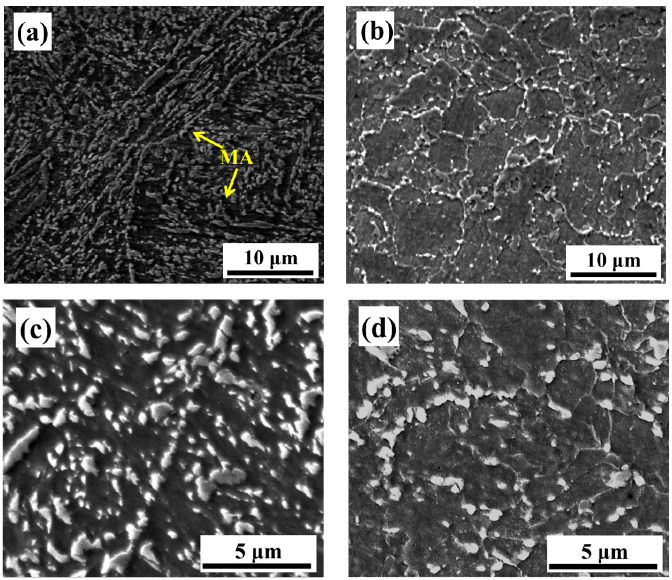
Figure 4. Microstructure of the weld metal for ( a ) as-welded and ( b ) post-weld heat treatment (PWHT) specimens; high magnification images of the weld metal for ( c ) as-welded and ( d ) PWHT